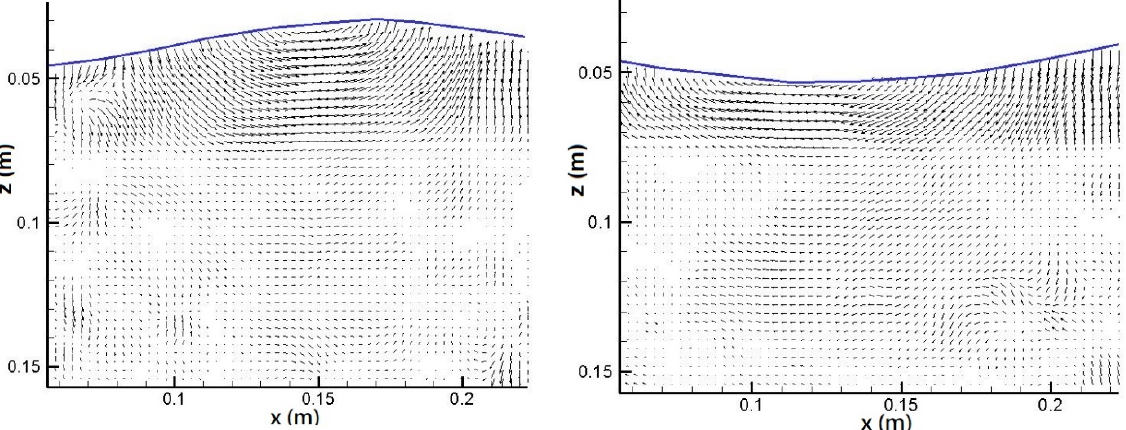
Figure 11. Velocity field and distribution of a short-period wave trough ( T = 0.5 s) passing through vegetation structures ( ϕ = 0.2 cm and d = 10 cm).